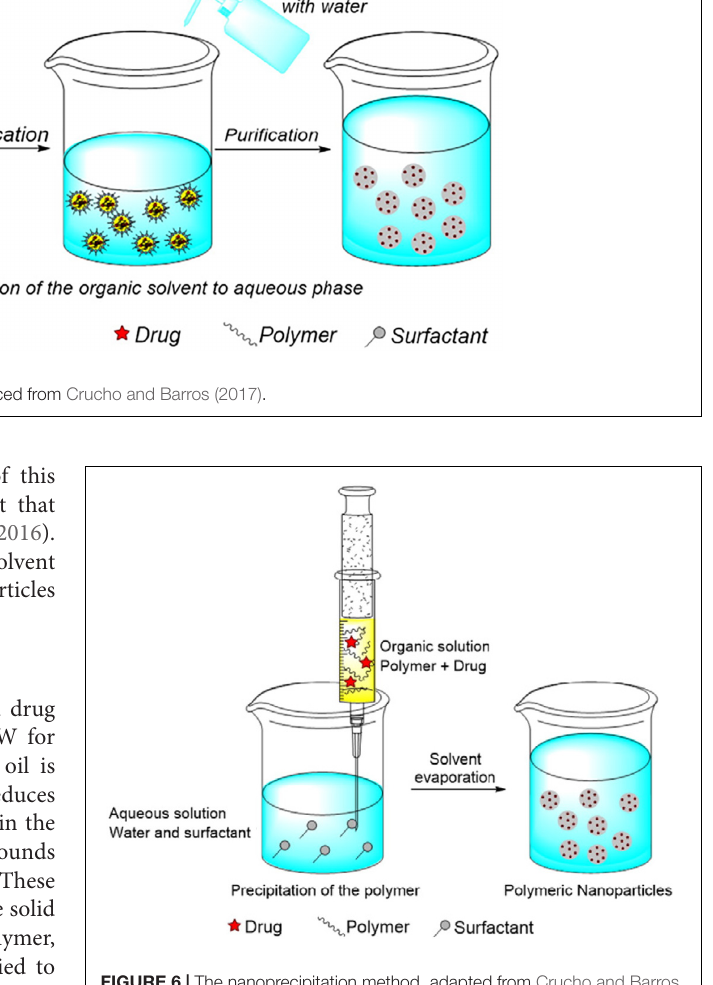
FIGURE 6 | The nanoprecipitation method, adapted from Crucho and Barros